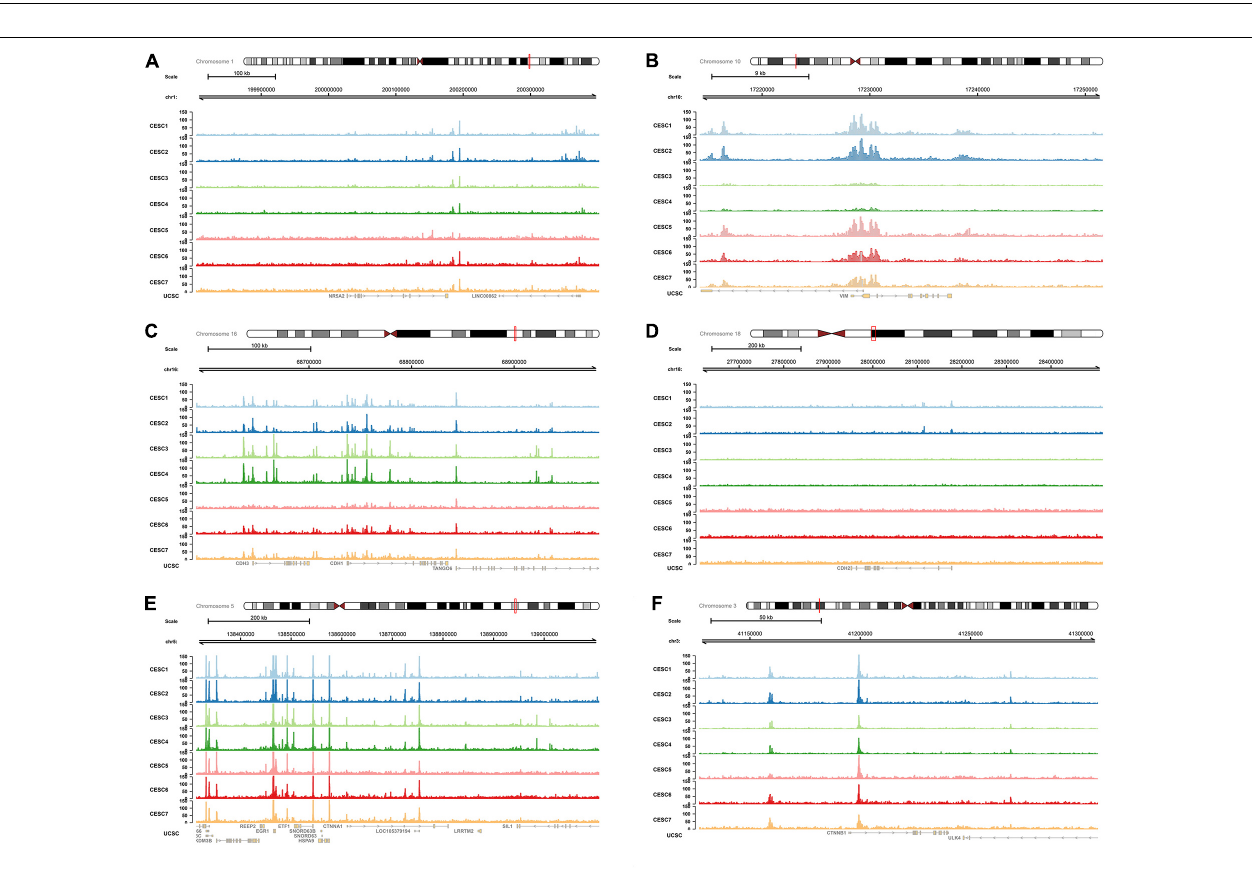
FIGURE 10 | ATAC-seq data validation. In ATAC-seq data of CESC, multiple peaks were identified in NR5A2 (A) , VIM (B) , CDH1 (C) , CDH2 (D) , CTNNA1 (E) , and CTNNB1 (F) sequences. ATAC-seq, assay for transposase-accessible Chromatin with high-throughput sequencing.